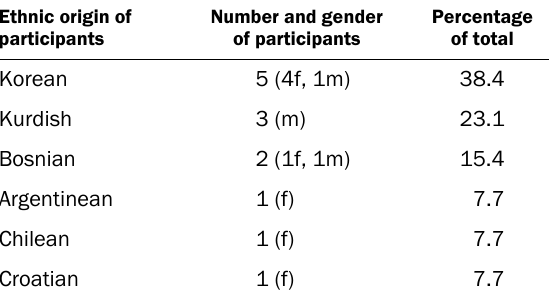
Table 1: SPIN-Farming Workshop